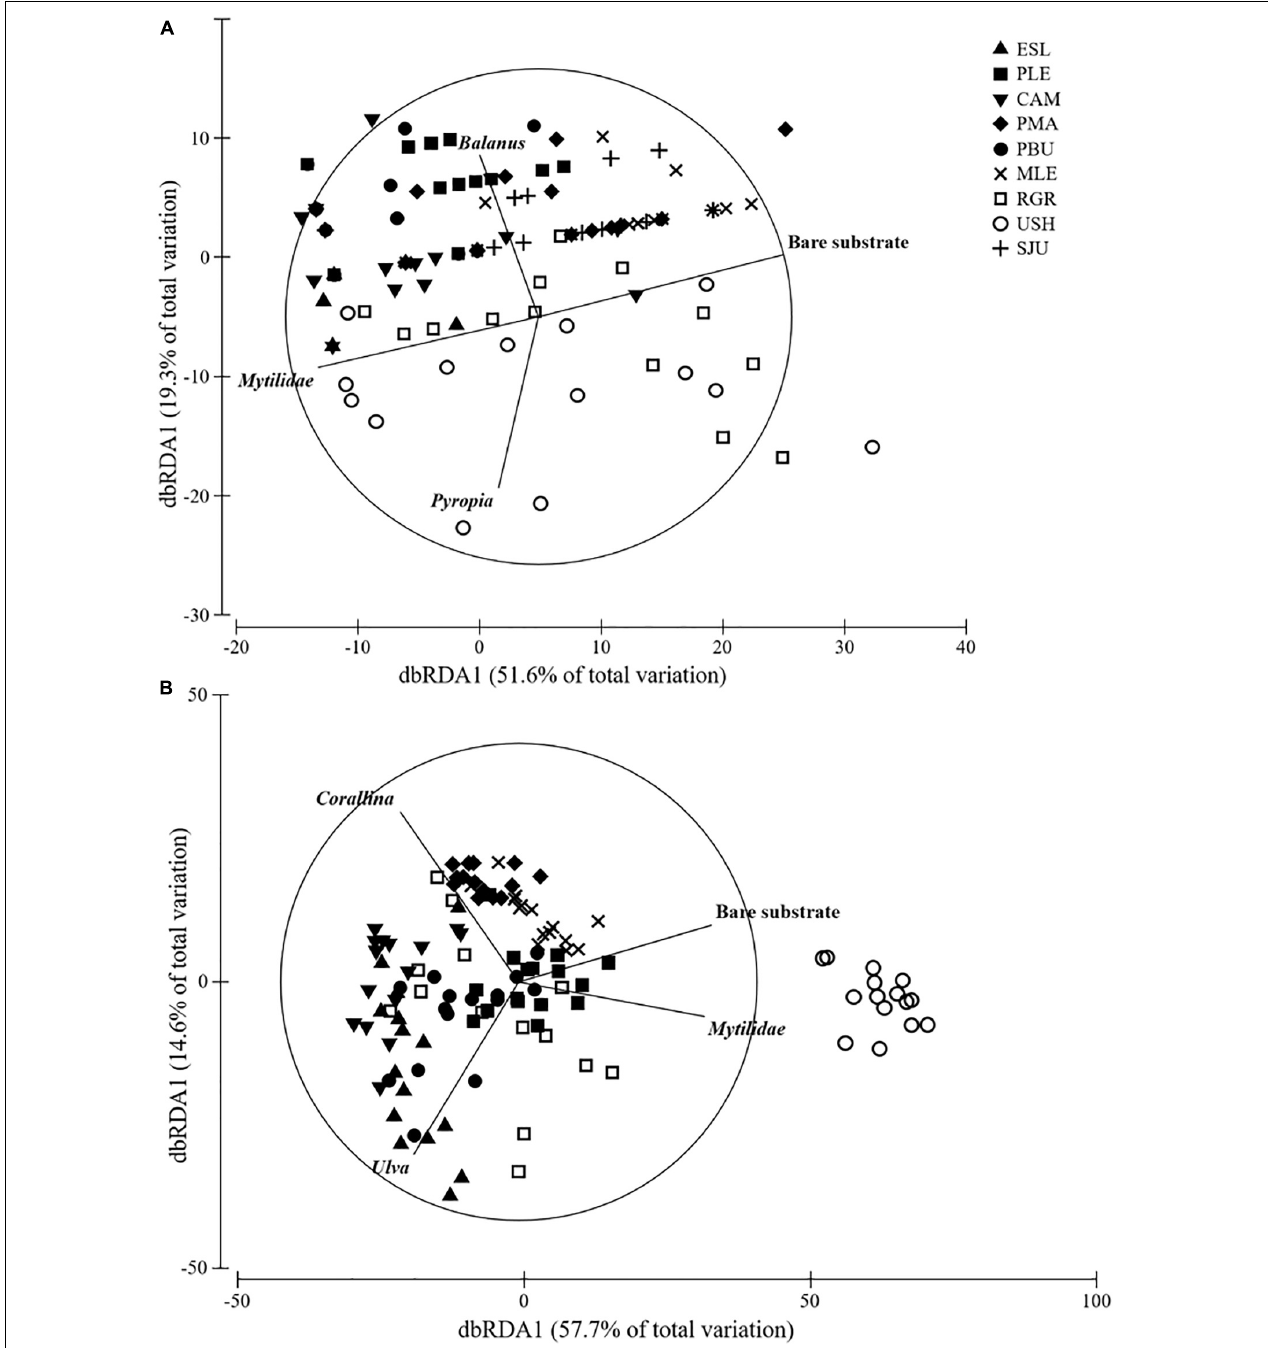
FIGURE 4 | DistLM analysis of (A) MT and (B) LT assemblages. Vectors show variables that had > 0.6 correlation